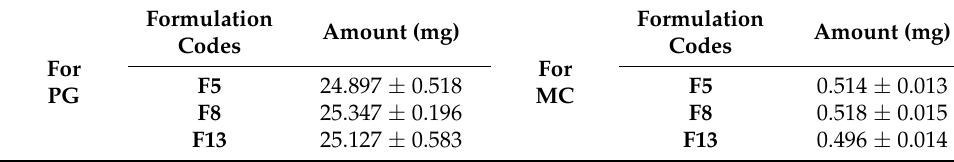
Table 6. Content uniformity results of OTFs ( n = 3, Table 3. PG and MC recovery % data after 72 h ( Ⴟ ± SD).